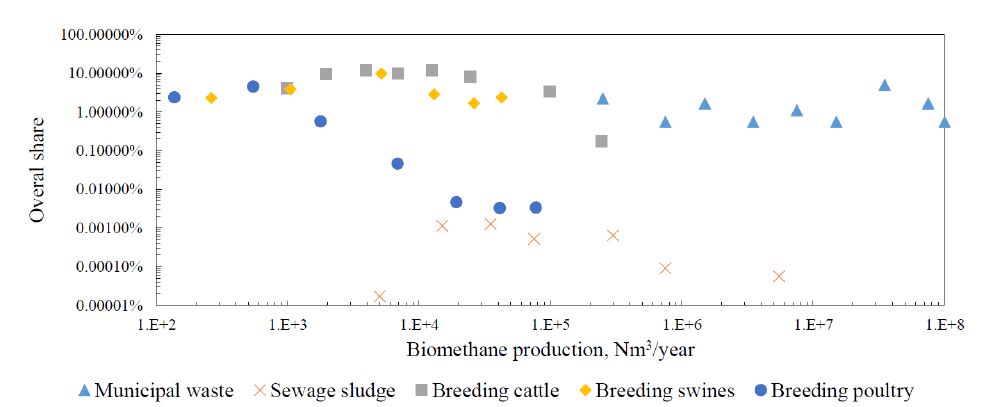
Figure 2. The size distribution of biomethane from all